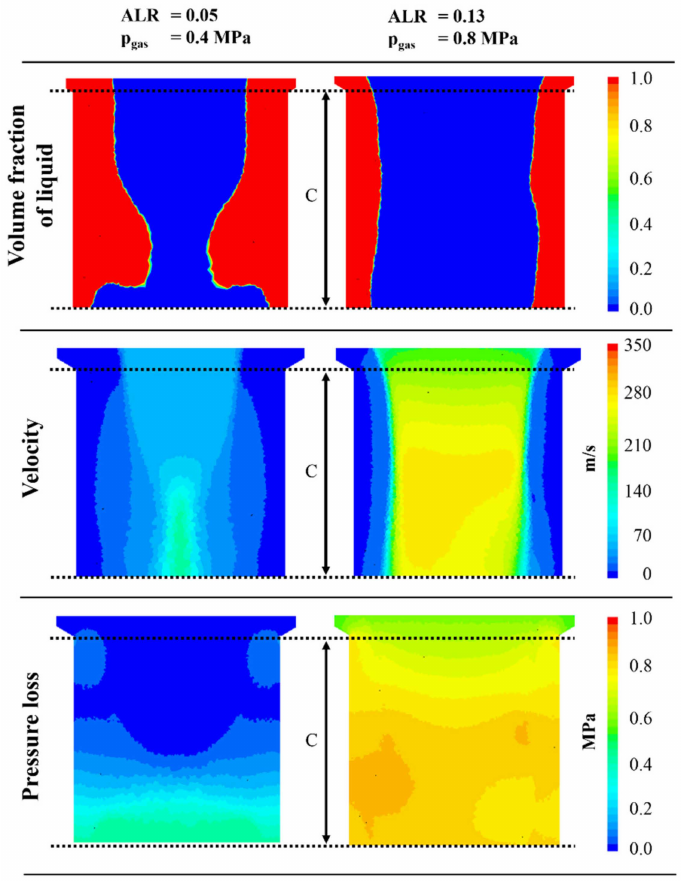
Figure 9. Profiles of the volume fraction of liquid ( top row ), velocity ( middle row ) and pressure loss in the atomizer ( bottom row ) at µ = 0.39 Pa · s and Q L = 40 L · h − 1 . Results at ALR = 0.05 and p gas = 0.4 MPa ( left ), as well as at ALR = 0.13 and p gas = 0.8 MPa ( right ) are